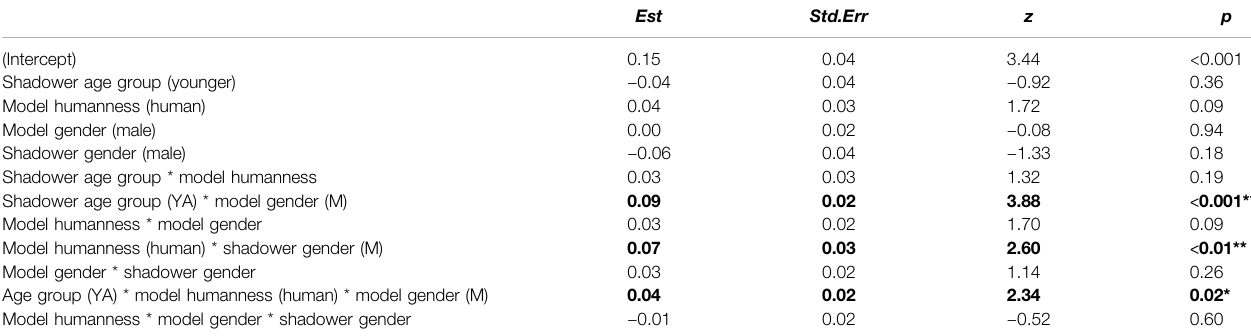
TABLE 1 | Summary statistics for the mixed effects logistic regression from the AXB task.